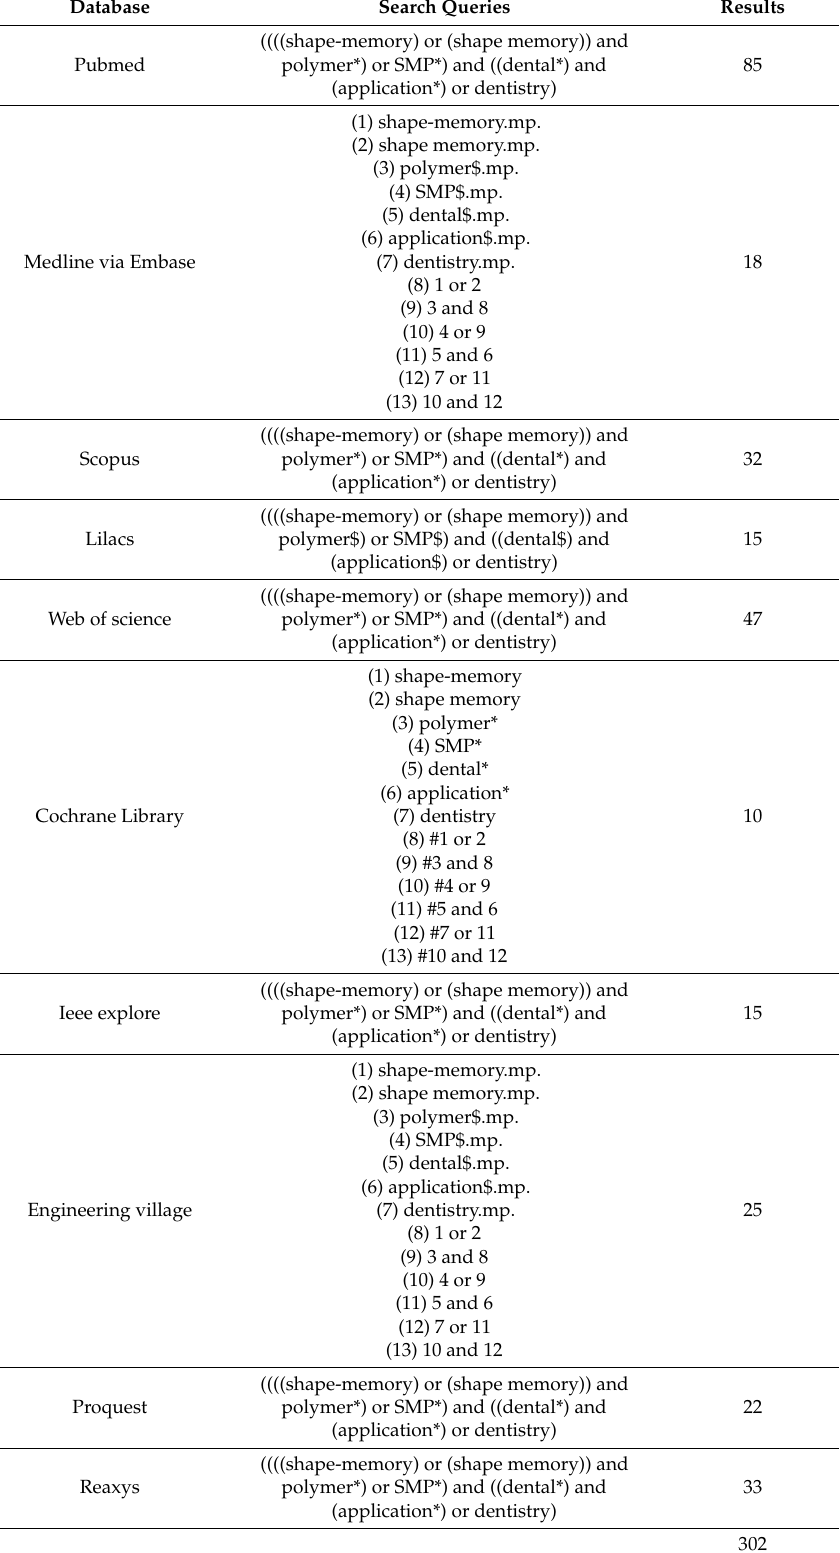
Table 3. Biomedical, Materials Science, Engineering and Chemical database search